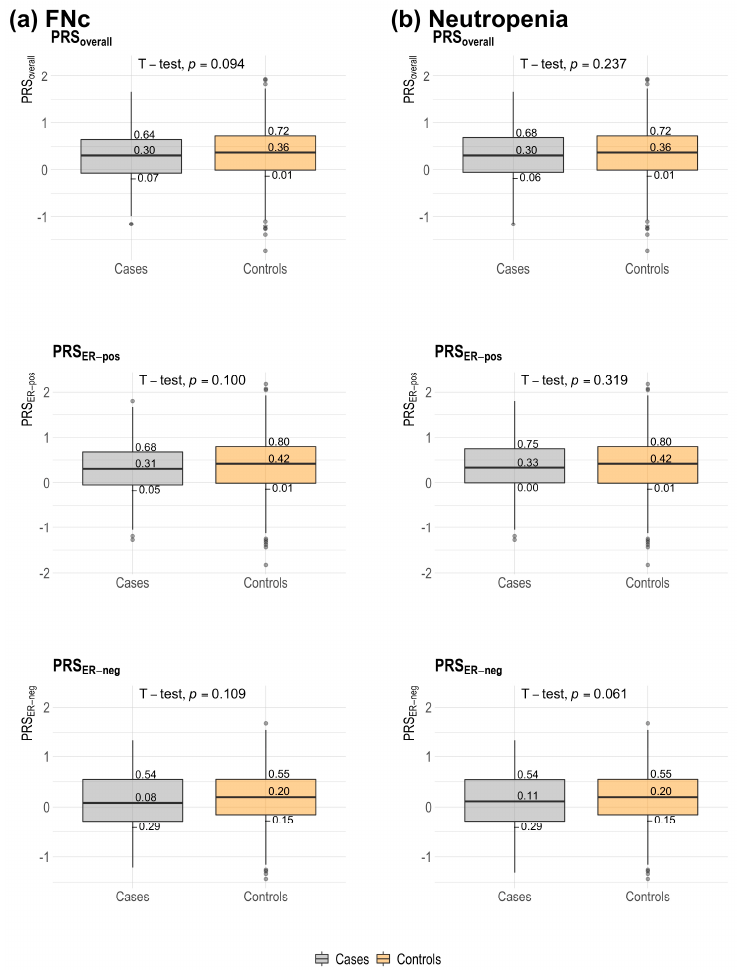
Figure 2. Distribution of 313-SNP breast cancer polygenic risk score (overall, estrogen receptor (ER)-positive, ER-negative) among breast cancer patients with neutropenia-related outcomes and non-neutropenia controls. Controls were chemotherapy-treated breast cancer patients who did not develop neutropenia. Median scores and quartile scores are displayed. A two-sample t -test was used for comparisons of medians; p -values are displayed. ( a ) FNc: febrile neutropenia from initiation of chemotherapy treatment (using taxanes or anthracyclines) to 30 days from last chemotherapy treatment cycle (i.e., within 30 days of last chemotherapy treatment); ( b ) neutropenia. PRS: polygenic risk score; PRS overall : overall PRS; ER: estrogen receptor; PRS ER-pos : ER-positive PRS; PRS ER-neg : ER-negative